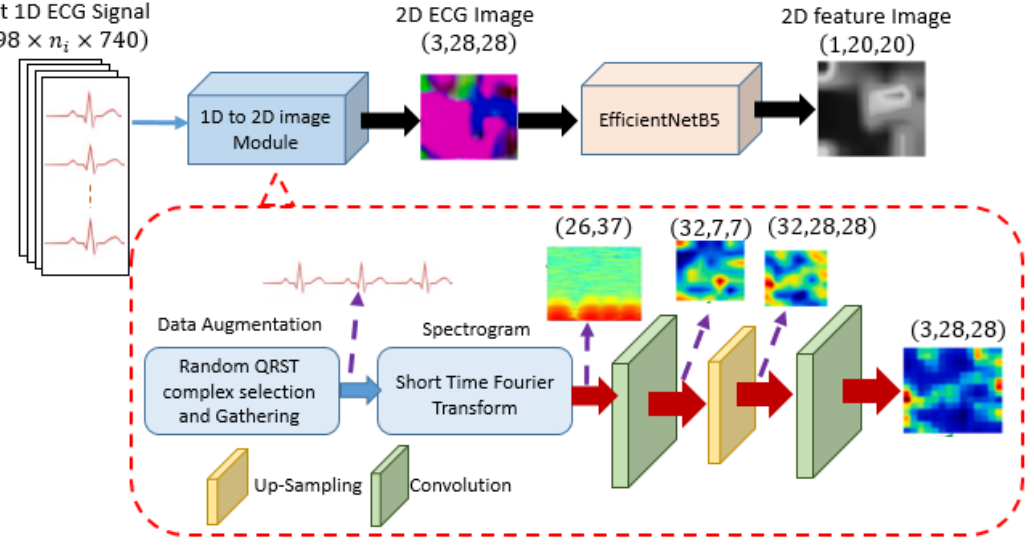
Figure 4. The feature extraction backbone, which is composed of two sub-blocks, 1D ECG signal to 2D image conversion block and 2D feature map generation block .